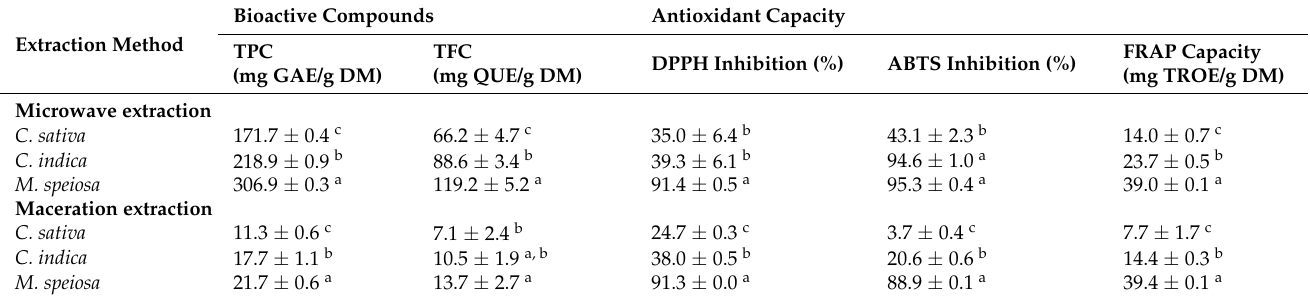
Table 1. The bioactive and antioxidative values of three plant leaves obtained via different extrac- tion